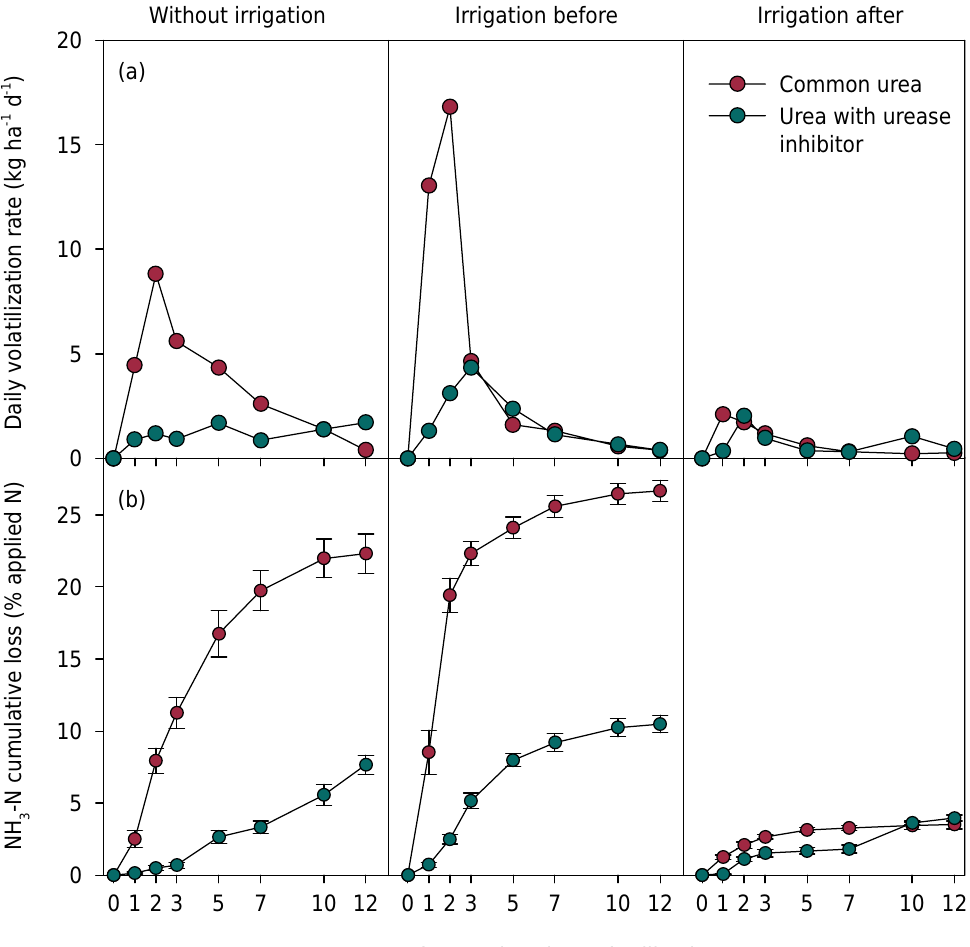
Figure 2. Daily volatilization rates (a) and NH 3 -N cumulative losses (b) from common urea and urea with a urease inhibitor applied to no-till corn under three different irrigation regimes, namely: without irrigation (the plots were protected from rain and dew on the day of fertilization and for 7 days after N fertilization), irrigation before (20 mm of water immediately before N fertilization), and irrigation after (20 mm water immediately after N fertilization). Vertical bars indicate mean standard